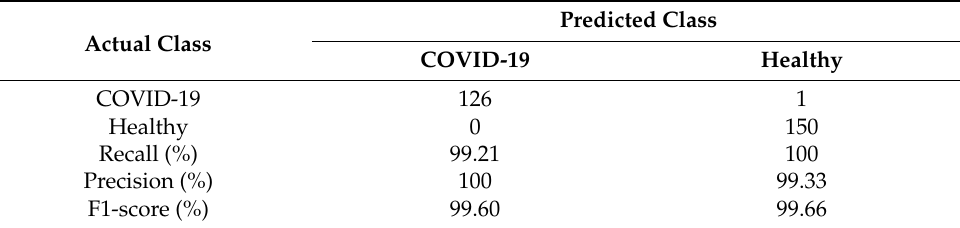
Table 6. Results obtained using our proposed Exemplar COVID-19FclNet9 model with DB4